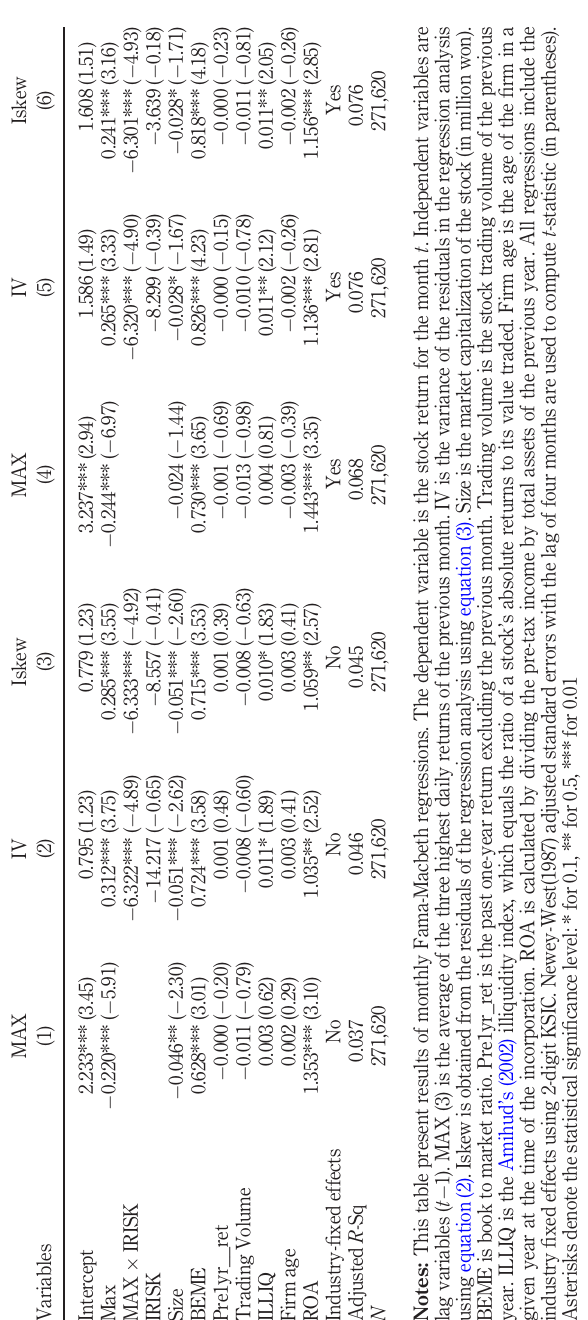
Table 4. Fama and MacBeth regressions: MAX(3) and idiosyncratic